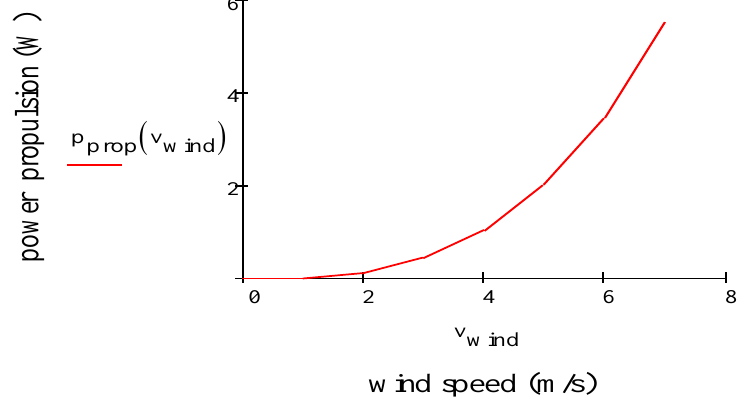
Figure 7. Power consumption of propulsion for one motor vs. wind speed.